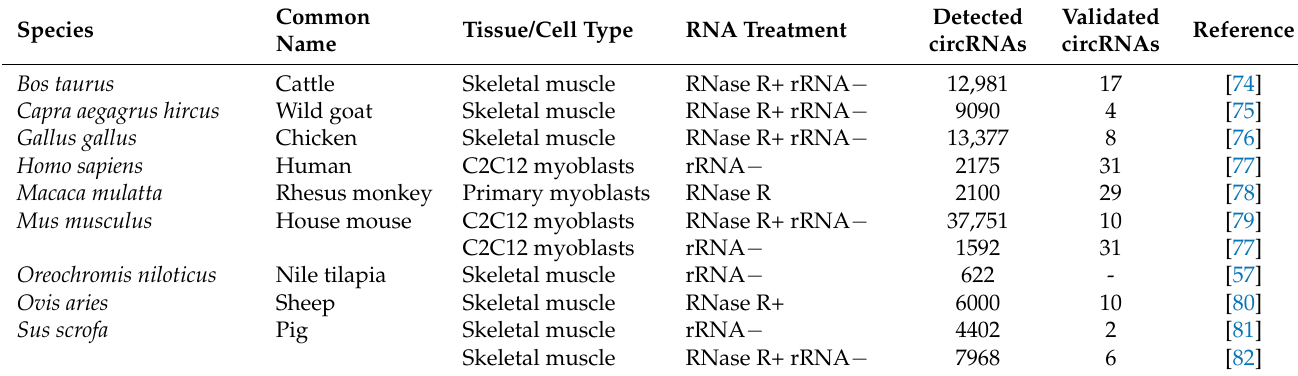
Table 1. Overview of circular RNA expression in vertebrate muscle. The type of RNA treatment used during the library preparation is indicated, along with the number of circRNAs detected in silico and experimentally validated by qPCR. Species